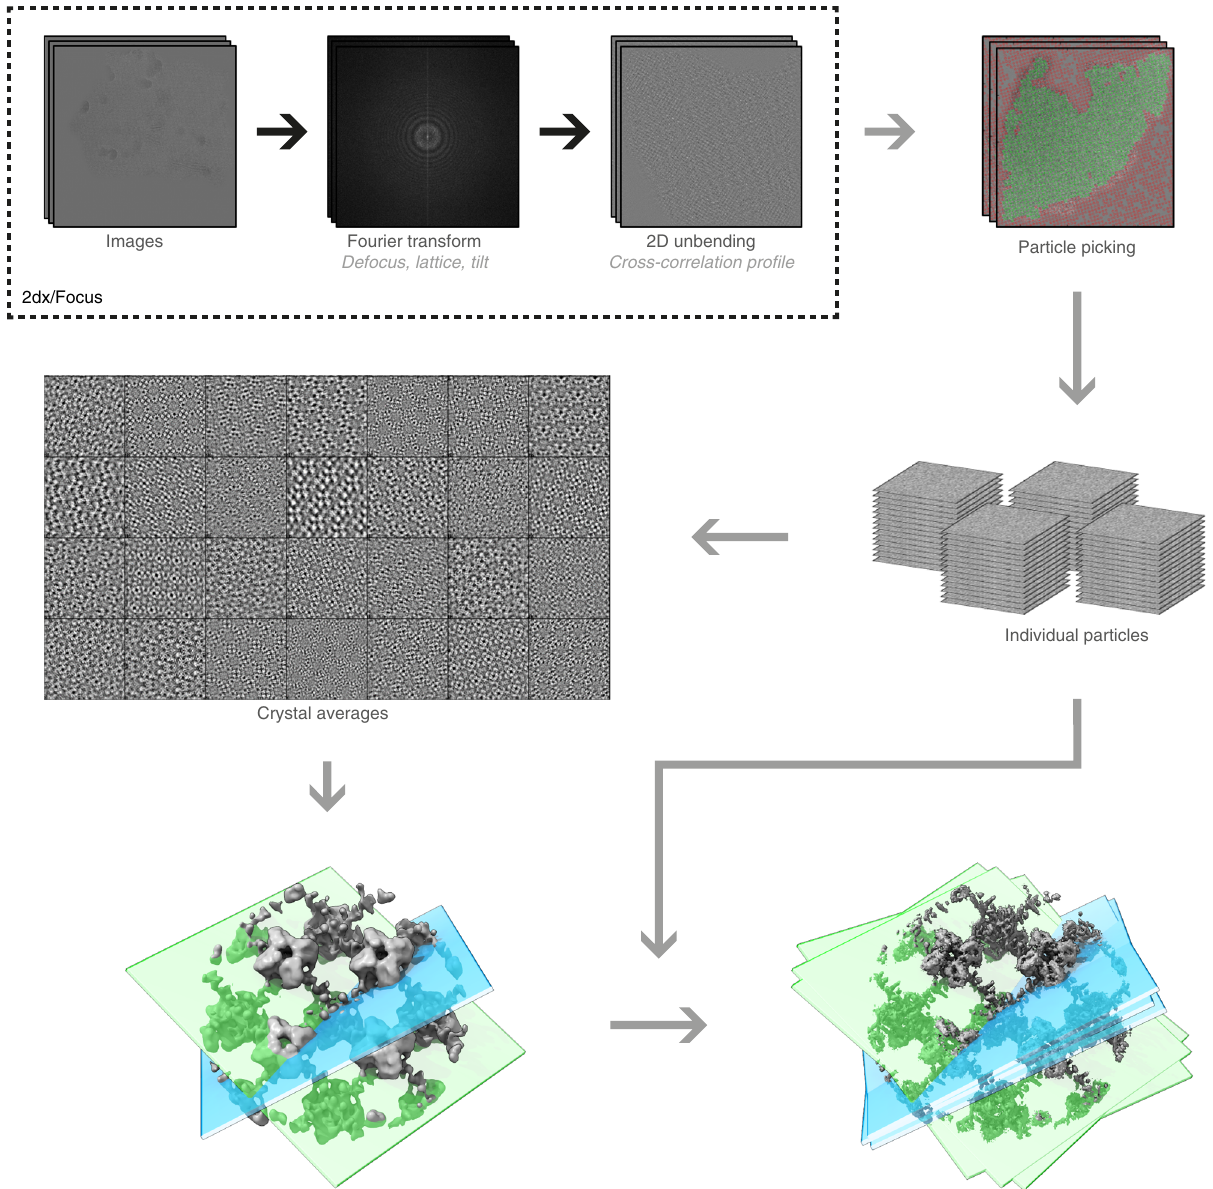
Fig. 1 Work fl ow employed to process 2D crystal data by single-particle analysis programs. Steps depicted within the dashed box were previously available in the 2D crystallography mode of FOCUS. A new GUI (Suppl. Fig. 1) was implemented to pick particles from the 2D crystals based on the unit cell positions obtained from classical unbending. Stacks of individual particles are then exported together with the associated metadata for processing with established SPA software. The particles extracted from the 2D crystal in each image are averaged in FOCUS for quality assessment, and rapid pre-re fi nement of the map is done with FREALIGN using these crystal averages as input. For simplicity, slices representing two crystal averages in different orientations are shown (light blue and light green). Then, the individual particles are initialized with the pre-re fi ned alignment parameters and provided to FREALIGN to perform a full re fi nement to high resolution. These individual particles might end up having slightly different orientations than the crystal average, due